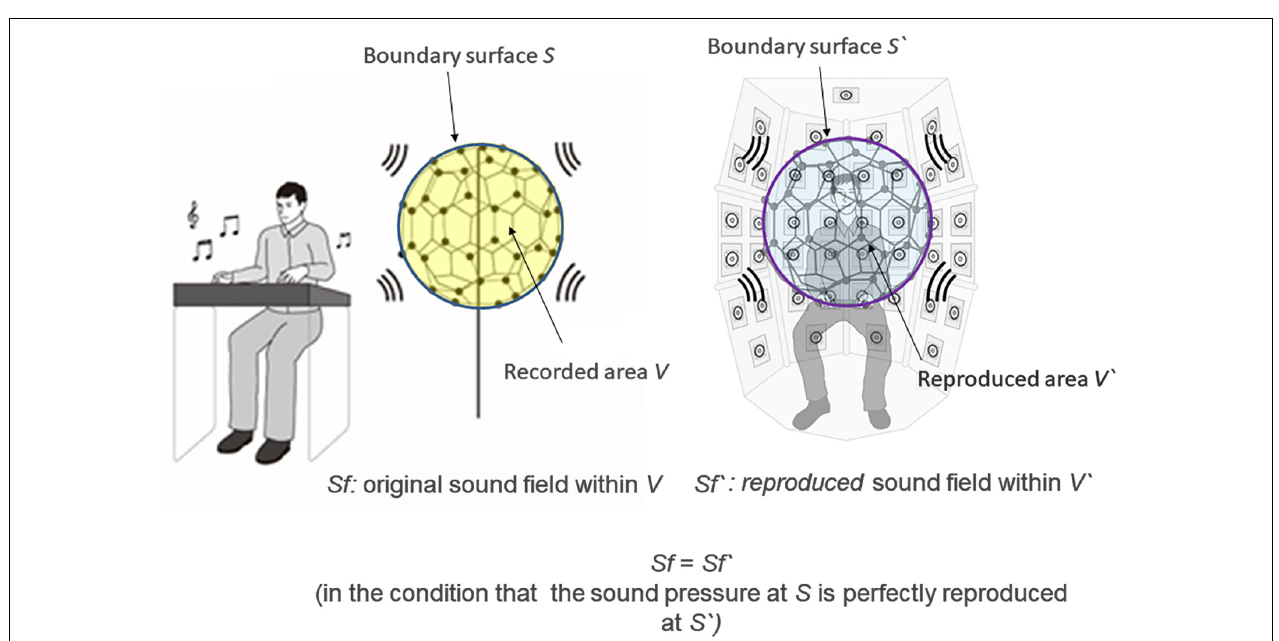
FIGURE 1 | Experimental equipment. (A) Photograph of fullerene-like microphone array with 80 channels of the BoSC system. (B) Photograph of reproduction system with 96 loudspeakers of the BoSC system. (C) Photograph of dummy head that had microphones in the position of the eardrums.